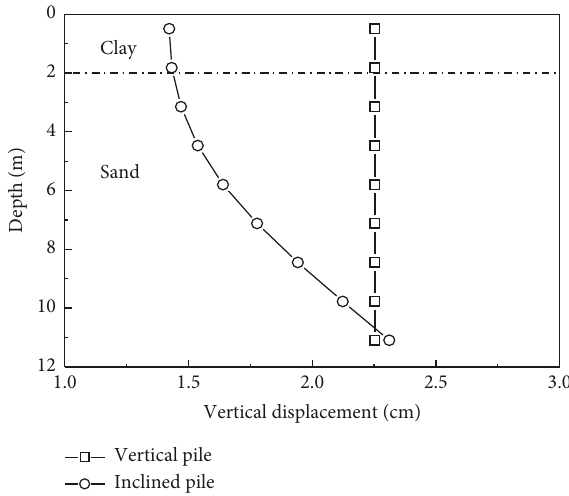
Figure 13: Pile moment and depth curve. Figure 14: Vertical displacement of the piles.